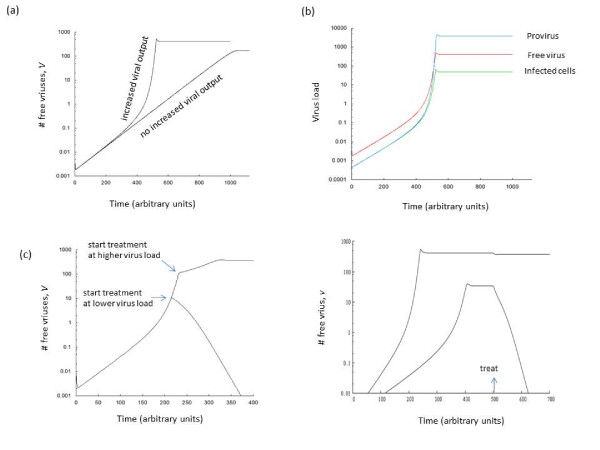
Effect of increased burst size in coinfected cells on the growth dynamics of the virus population. (a) Two growth curves are plotted. If no increased burst size is assumed in coinfected cells, then a straight exponential phase of virus growth is observed. In the presence of an increased burst size in coinfected cells, however, the exponential rate of virus growth increases as virus load rises over time. Hence increased viral output in coinfected cells speeds up virus growth significantly. The graph also shows that an increased burst size in coinfected cells leads to a higher equilibrium virus load. (b) This graph shows that for the case of an increased burst size in coinfected cells, different measures of virus load do not necessarily correlate with each other as virus load grows, especially at higher virus loads. This is because the rate of virus production per infected cell increases with higher virus loads. Free virus is given by v in the model, the number of infected cells by ΣIi, and provirus is given by the total number of integrated genomes. (c) Increased burst size in coinfected cells and treatment dynamics. Treatment is assumed to reduce the overall viral replication rate to a certain degree. Two curves are shown, where treatment is started at different times. The parameters and the treatment strength are identical for the two curves. If treatment is started earlier when virus load is relatively low, the virus population is suppressed by the drug because the overall rate of viral replication is relatively low. On the other hand, when treatment is started later when virus load is higher, a larger number of coinfected cells with increased viral output leads to faster viral replication kinetics such that the drug is not potent enough anymore to control the virus population. (d) Same principle, but demonstrated in an equilibrium setting. If equilibrium virus load is relatively low, treatment is successful. If equilibrium virus load is higher, treatment can be unsuccessful due to the larger burst size of multiply infected cells. Parameters were chosen as follows. (a,b) λ = 10; d = 0.1; β = 0.027; a = 0.2; k = 4; u = 1; ϵ = 1; g = 0.75; η = 0.5; n = 200. (c,d) λ = 10; d = 0.1; β = 0.03; a = 0.2; k = 4; u = 1; ϵ = 1; g = 0.75; η = 0.5; n = 200. . During treatment, the viral infection rate was reduced to β = 0.015.